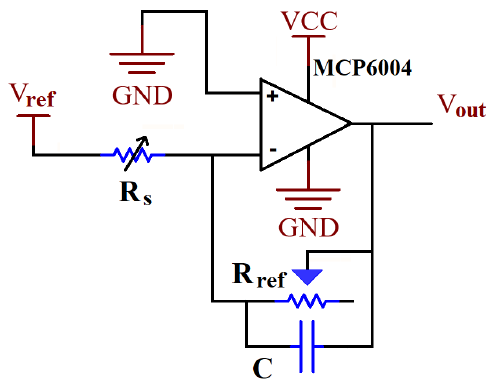
Figure 2. Circuit schematic of the FSR sensors: V ref is the supplied voltage at − 1.1 V, R ref is a potentiometer of 100 k Ω , R s is the resistance of the FSR, C is a capacitor of 47 pF, and the MCP6004 is a four-channel low-power operational